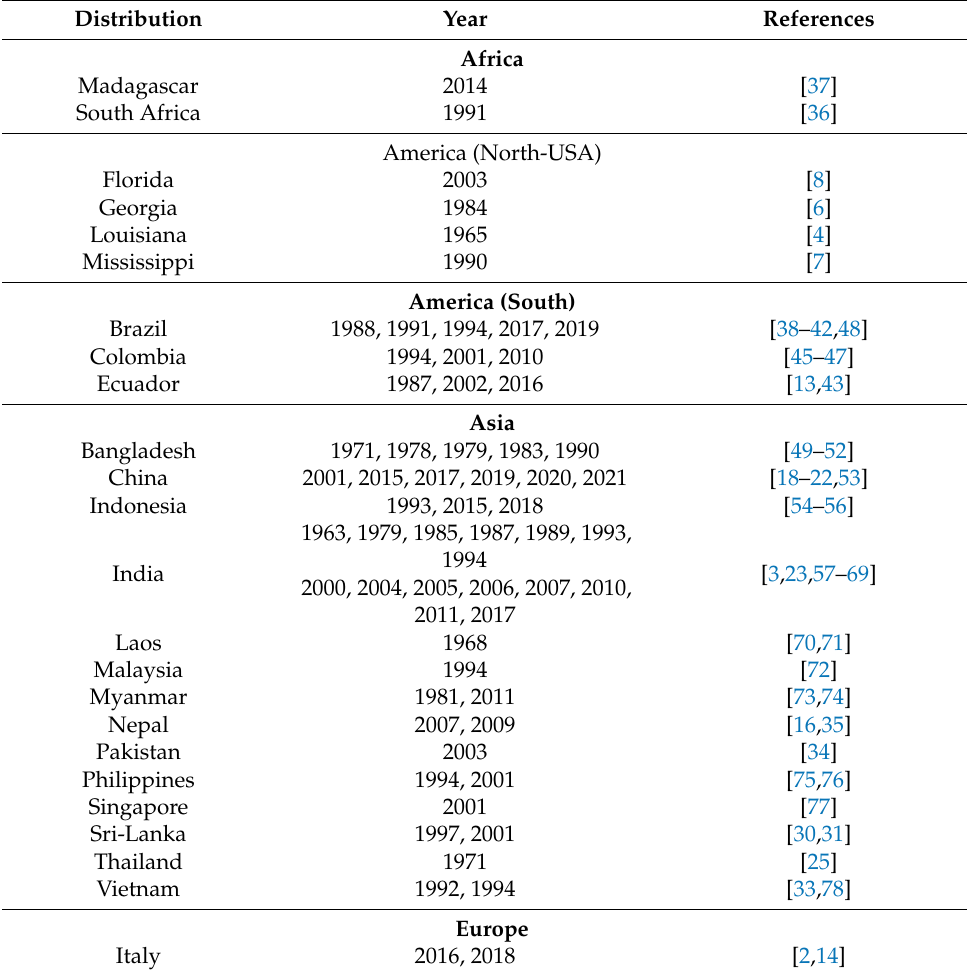
Table 1. Distribution of Meloidogyne graminicola in Africa, America, Asia, and Europe.